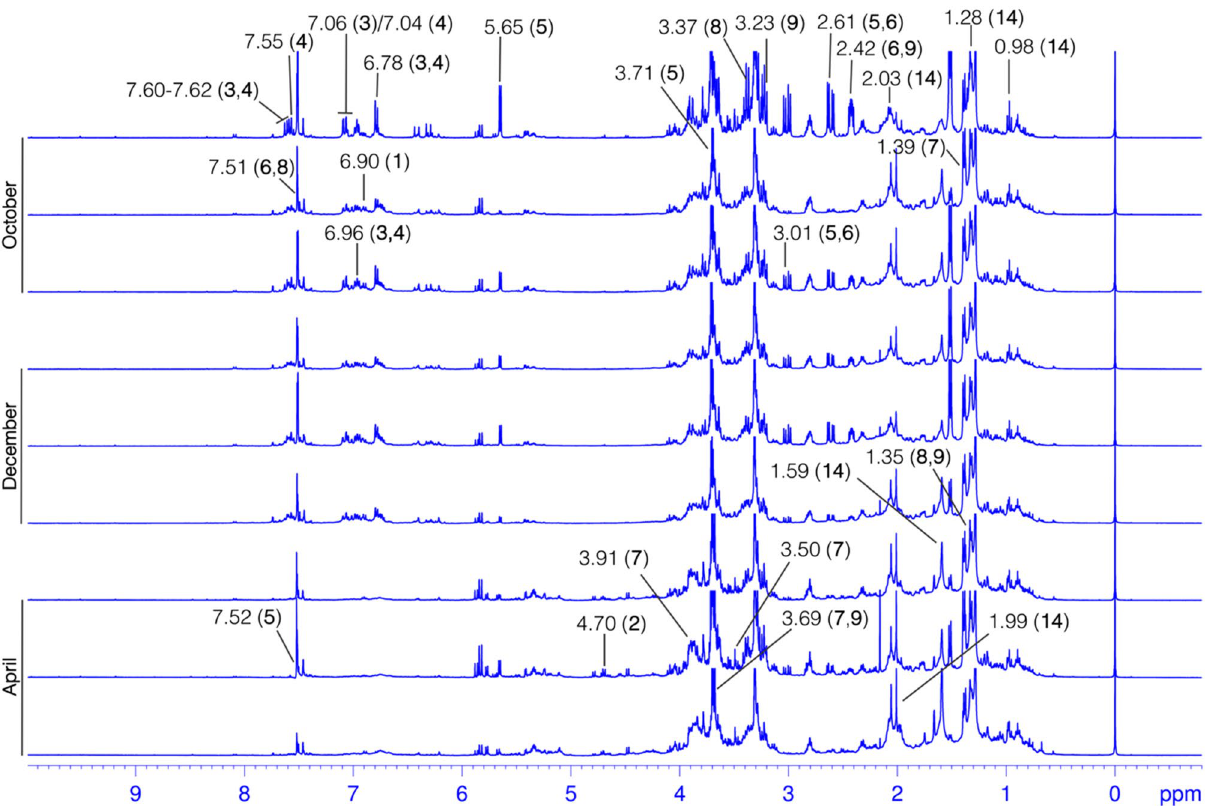
Figure 5. Stacked spectra of 1 H HR-MAS NMR exhibiting peaks of the discriminatory metabolites in comparison with PCA. NMR data were processed in TopSpin v3.6.3 software package and preprocessed in analysis of mixture (AMIX) v3.9.12 software package (Bruker BioSpin: https:// www. bruker. com), PCA analysis was performed in the MetaboAnalyst v5.0 (https:// www. metab oanal yst. ca/). Representations for discriminatory metabolites indicating main variables in the loading plot were manually produced in Microsoft PowerPoint v16.56 (https:// offic ecdnm ac. micro soft. com), and the GIMP v2.10.24 software package (https:// www. gimp. org) was used for final figure generation. PCA group legends: Br-April (Autumn), the month of April is mid- Autumn in Brazil; Br-Oct (Spring), October is early Spring in Brazil; Br-Dec (Autumn), the month of December is late-Spring in Brazil. Loading variables and metabolites: 1 , kaempferol-3- O -dihexoside; 2 , caffeoyl glucoside; 3 , 3- O -caffeoylquinic acid; 4 , 5- O -caffeoylquinic acid; 5 , kingiside; 6 , 8-epi-kingisidic acid; 7 , (7 α )-7- O - methylmorroniside; 8 , (7 β )-7- O -methylmorroniside; 9 , alpigenoside; 14 , fatty (linolenic) are in agreement with the 1 H HR-MAS NMR result (Fig. 5). The variables in PCA loading are equivalent to 1 H HR-MAS NMR peaks or chemical shifts of the protons in individual metabolites. To better apprehend seasonal and environmental correlation with (sub)groups and metabolites, a conjoined analysis of PCA (Fig. 4) and 1 H HR-MAS NMR (Fig. 5) is highlighted. In accordance with PCA analysis, samples in a large group were described by several NMR peaks, represent- ing the protons in sugar, metabolites 1 – 9 , and 14 . 1 H HR-MAS NMR (Fig. 5) exposed that sugar (δ H 3.77) along with 1 allowed group discernment on the basis of aromatic ring protons of H-3 ′ /H-5 ′ (δ H 6.90, m). Group clas- sification by metabolites 2 and 3 was established through a vinylic proton of H-7 [(δ H 7.60, d, J = 15.9 Hz), H-7 (δ H 7.62, d, J = 15.9 Hz)]. Further peaks from 3 included the aromatic ring protons of H-2 (δ H 7.06, d, J = 2.0 Hz), H-5 (δ H 6.78, d, J = 8.2) and H-6 (δ H 6.96, dd, J = 8.2; 2.0 Hz), while several other from 4 incorporated the aro- matic ring protons of H-2 (δ